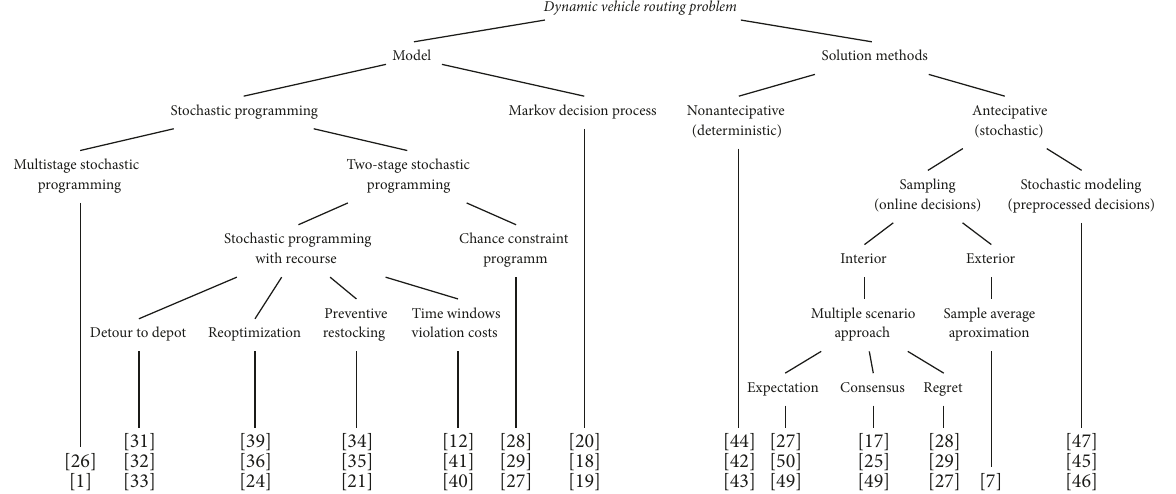
Figure 1: Papers dealing with dynamic vehicle routing